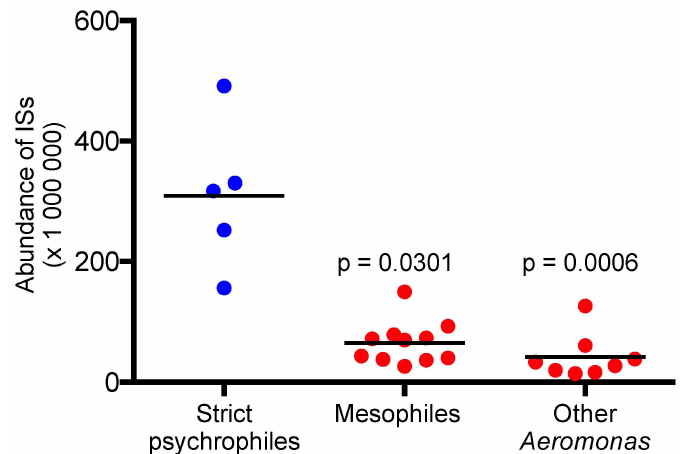
Figure 2. Percentage of sequencing reads mapped by diamond (blastx algorithm) against the database of insertion sequence transposases provided by Prokka [45]. The values were standardized to consider the lengths of the proteins and the depth of the datasets, as was done previously [15]. The same dataset was used as for the phylogenetic analysis (Figure 1). A Kruskal–Wallis test with a Dunn’s multiple test comparison was performed using PRISM 6